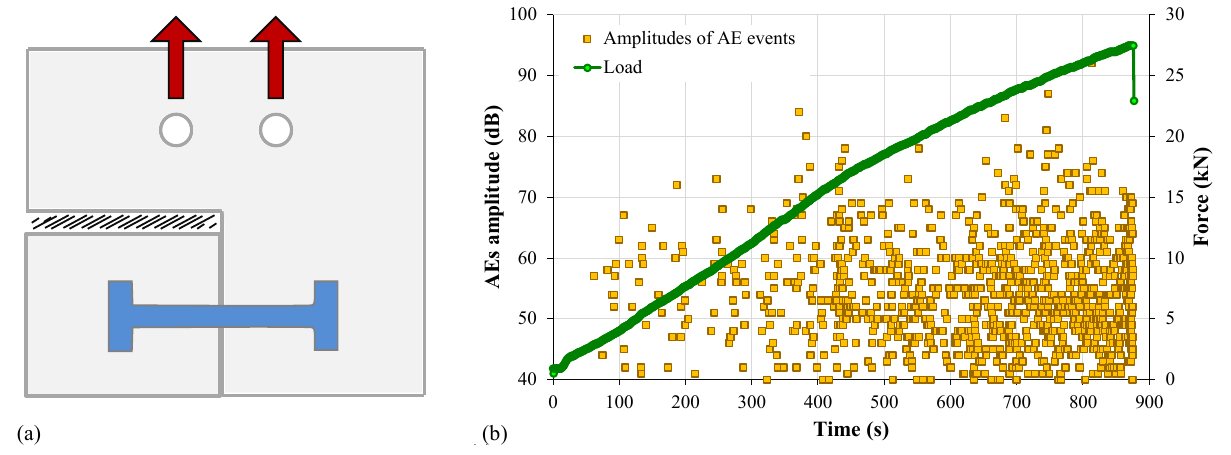
Figure 11. ( a ) Sketch of the mutually interconnected marble blocks. The red arrows indicate the direction of the imposed force. ( b ) The temporal evolution of the amplitudes of the acoustic events recorded in juxtaposition to the force imposed. Appl. Sci. 2022 , 12 , x FOR PEER REVIEW